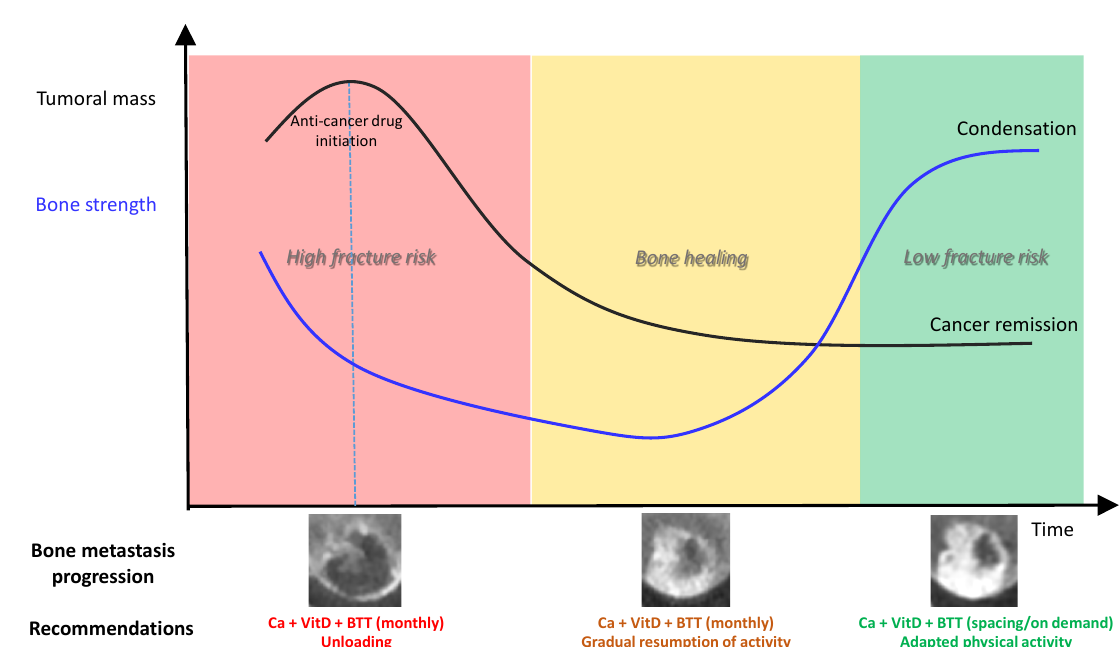
Figure 5. Conceptual model of bone strength progression according to osteolytic bone metastasis response to anti-cancer drug. BTT, bone-targeted treatments.